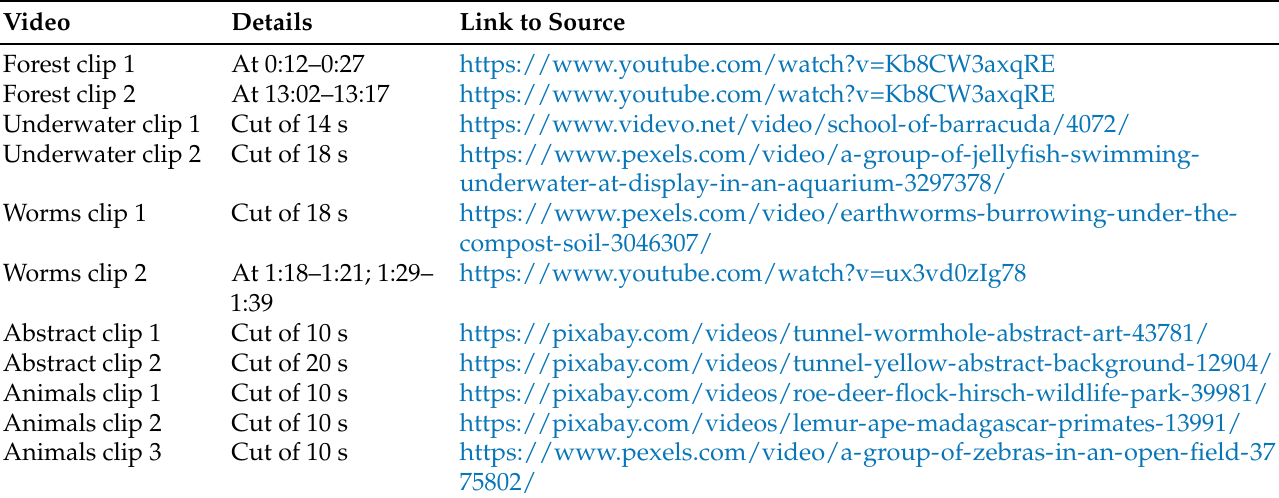
Table A1. Sources of video footage shown to